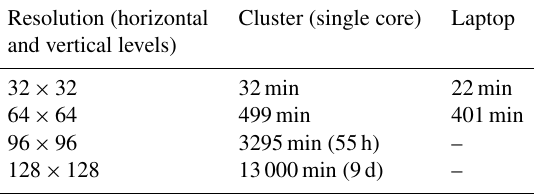
Table 6. A table outlining model run times of varying resolution between a computational cluster comprised of Intel Xeon E5-2650 v3 CPUs and a 2015 Mac laptop running macOS Catalina (ver- sion 10.15.7) for 20 model years, for both computing systems, the model is run on a single core. The highest resolution simulation (128 × 128 horizontal and vertical levels) was conducted on the clus- ter only due to computational constraints on a